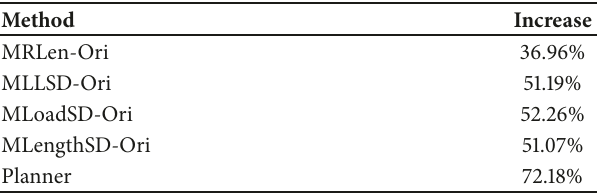
Table 4: Cost relative to perfect